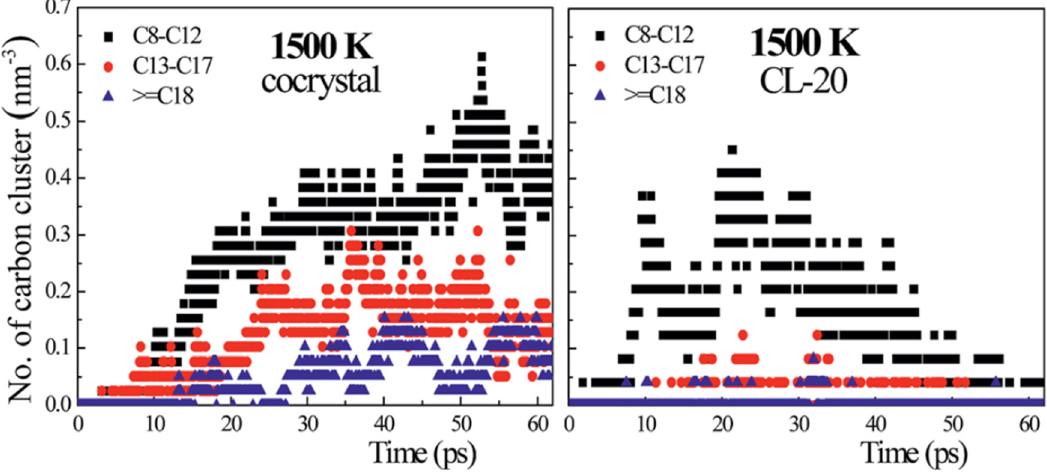
Figure 4: Time evolution of three types of carbon cluster for cocrystal and CL - 20. Larger and more carbon aggregates, which slow energy release in chemical reactions, were observed in the cocrystal system [ 118 ] .